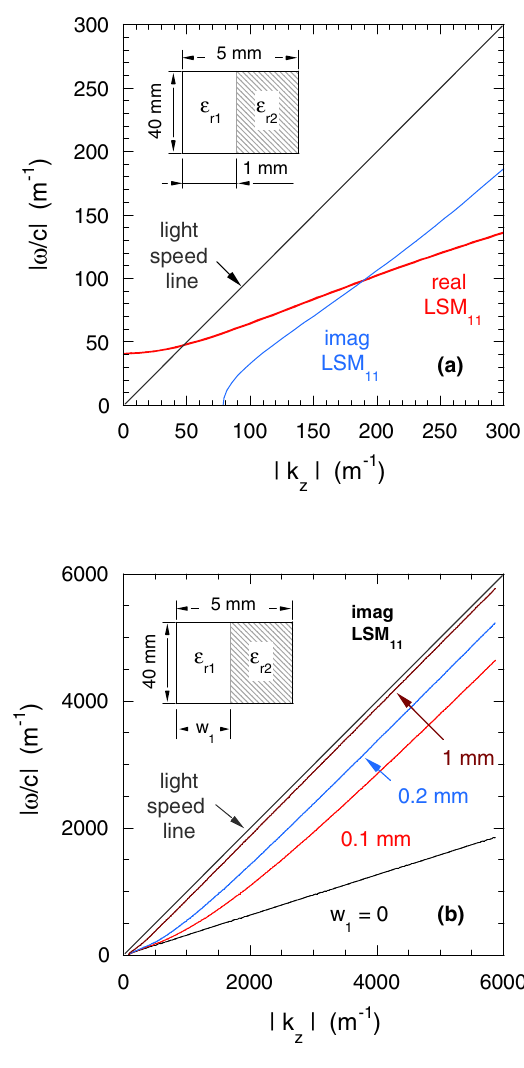
FIG. 2. (Color) (a) Both real and imaginary LSM mode dis- 11 (cid:4) 1 mm in a two-zone persion curves for a vacuum gap of w 1 rectangular DLW structure, with a width of 5 mm and a height of - and LSE -mode (cid:4) 1 , " (cid:4) 10 , and (cid:1) (cid:4) (cid:1) (cid:4) 1 ; (b) Only 40 mm, with " 11 11 r 1 r 2 r 1 r 2 -mode dispersion curves for various vacuum imaginary LSM 11 . It is seen from (a) that the imaginary curve can gap widths w 1 (cid:1) 0 intersect the real curve, and from (b) that the curves with w 1 j is large enough, become parallel to the light speed line when j k z correspond although the smaller the gap width, the larger is the modulus of ph k before the dispersion curve becomes parallel to the light z